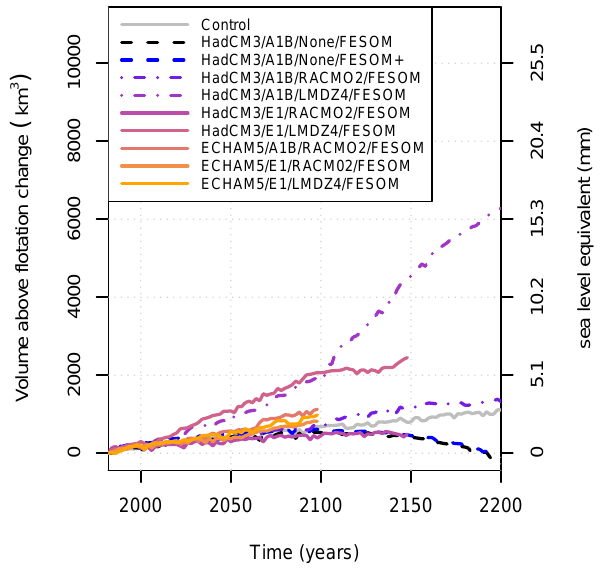
Figure 7. Evolution of the volume above flotation due to climate model forcing. Simulations up to 2100 lead to up to 5mm of sea level fall in excess of the control run. Dy- namic thinning in response to increased FESOM ocean forcing during the 22nd century leads to 3mm of sea level rise by 2200 in the absence of increased accumulation (HadCM3/A1B/None/FESOM,HadCM3/A1B/None/FESOM+), but this figure is balanced by the HADCM/A1B/RACMO2 surface mass balance anomalies, and easily outweighed by the HADCM/A1B/LMDZ4 anomalies to give 15mm of sea level